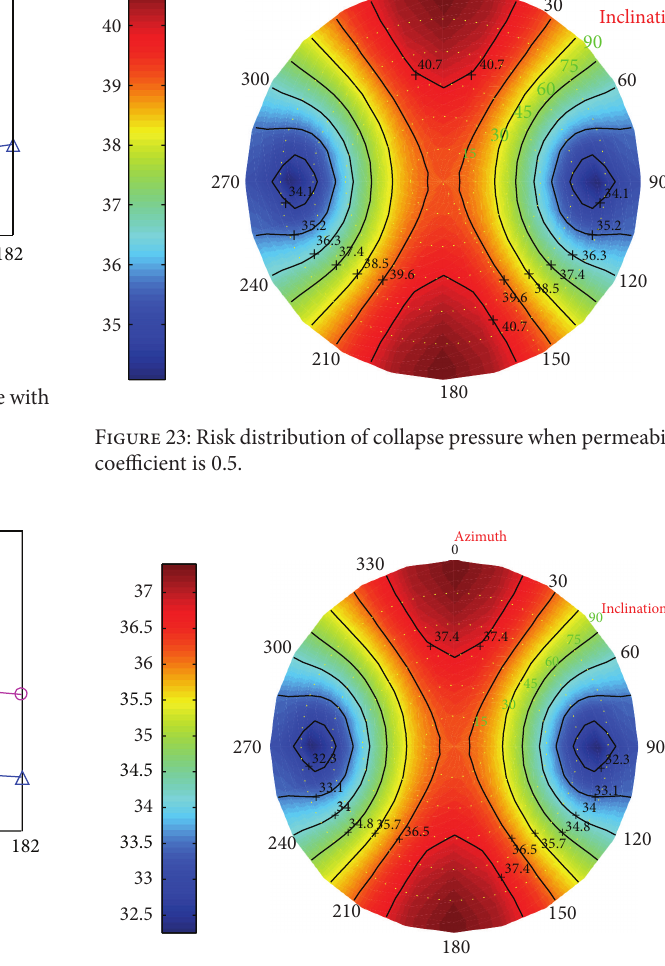
Figure 21: Variation of collapse pressure and fracture pressure with temperature decrease.